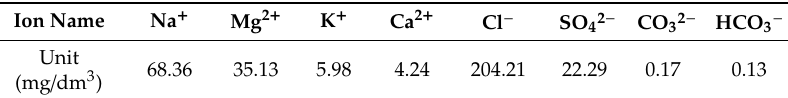
Table 3. Chemical composition of Qinghai Salt Lake,